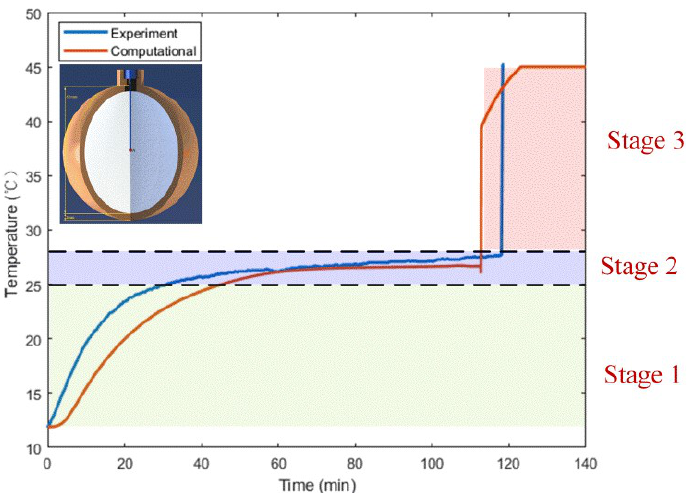
Figure 7. Comparison of the computational and measured temperatures at the central point of the spherical container during the constrained melting process with 𝑅 = 31.02 mm and 𝑇 (cid:3050) = 318.15 K .